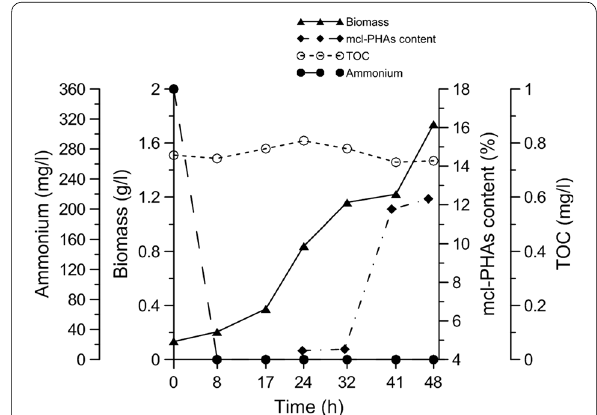
Fig. 2 Growth and mcl‑PHAs accumulation during 48 h cultivation of P. putida KT2440 relA/spoT mutant in